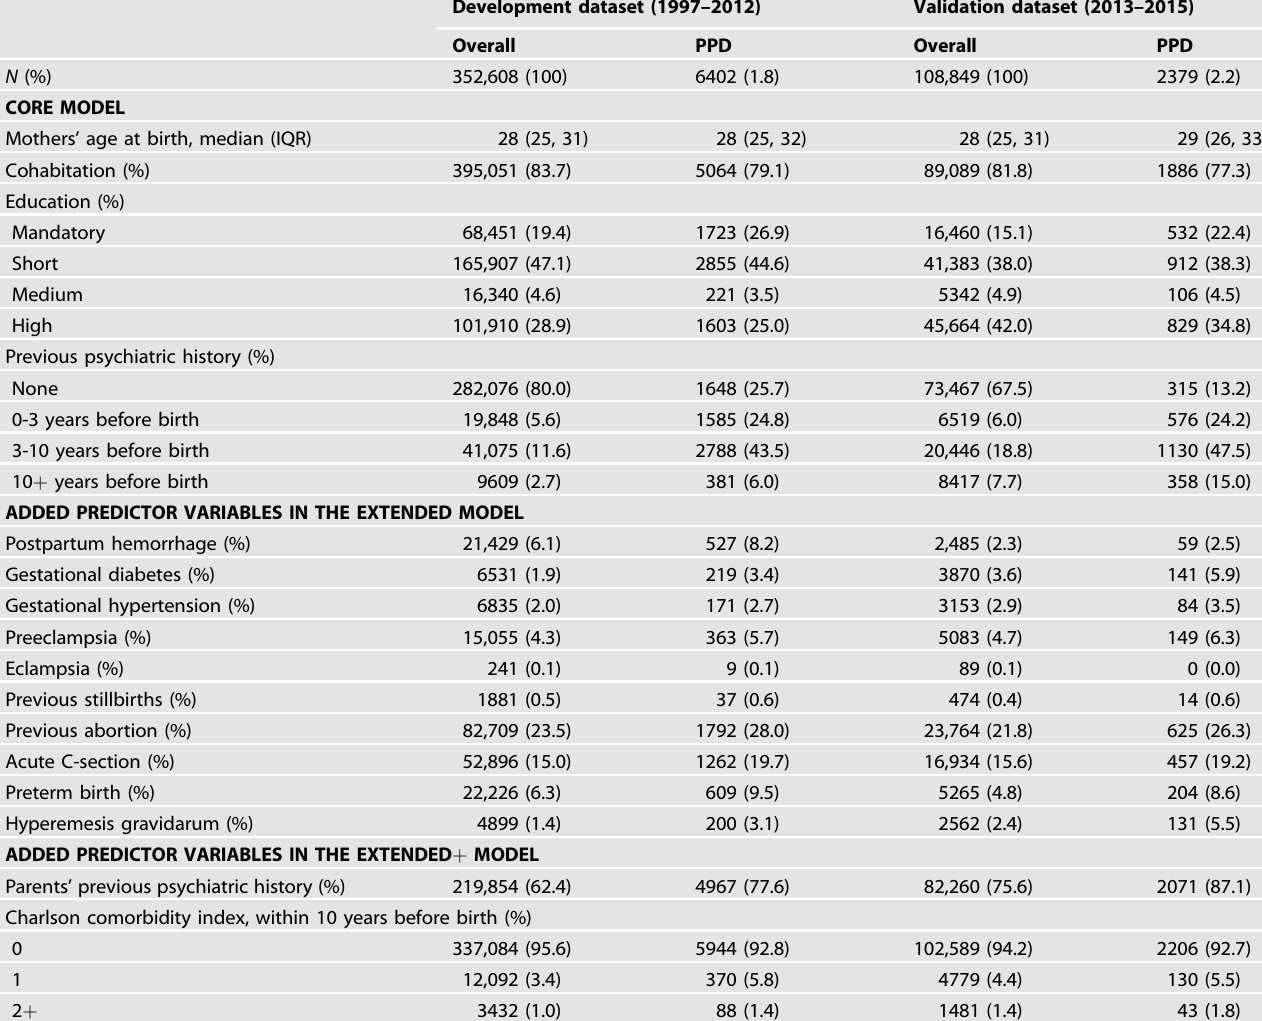
Table 1. Baseline characteristics of 352,608 mothers (development dataset) and 108,849 women (validation